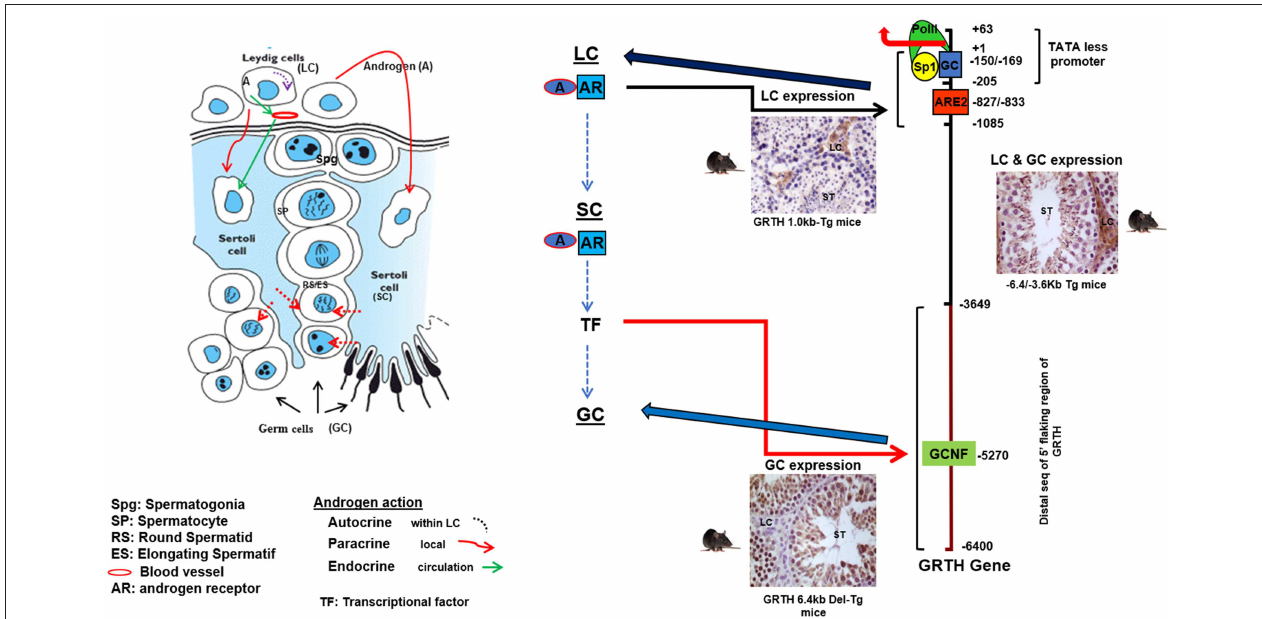
FIGURE 2 | Androgen (A) regulated GRTH expression in cell compartments. Diagram elucidating the 5 ′ -flanking sequence of GRTH gene that directs its cell-specific expression in testicular cells and direct/indirect actions of androgen on GRTH transcription at cellular compartments. A produced from LCs binds to AR and subsequently interacts with ARE2 ( − 828/ − 833) to direct GRTH gene expression in LCs. Paracrine activation (yet to be identify) by androgen from LC induces A/AR-responsive gene(s) expression in Sertoli cells. These in turn may activate downstream targets that directly or indirectly induce GRTH transcription through GCNF binding to 5 ′ elements located in the distal ( − 3,600/ − 6,450 bp) 5 ′ -flanking region of the gene (17, 21, 22).